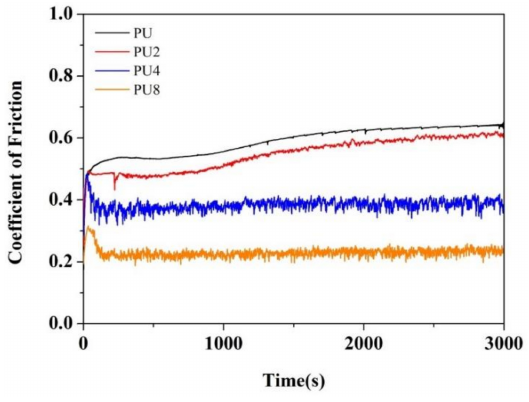
Figure 9. Coefficient of friction versus sliding time for PU coating and PU/Gr composite coatings.